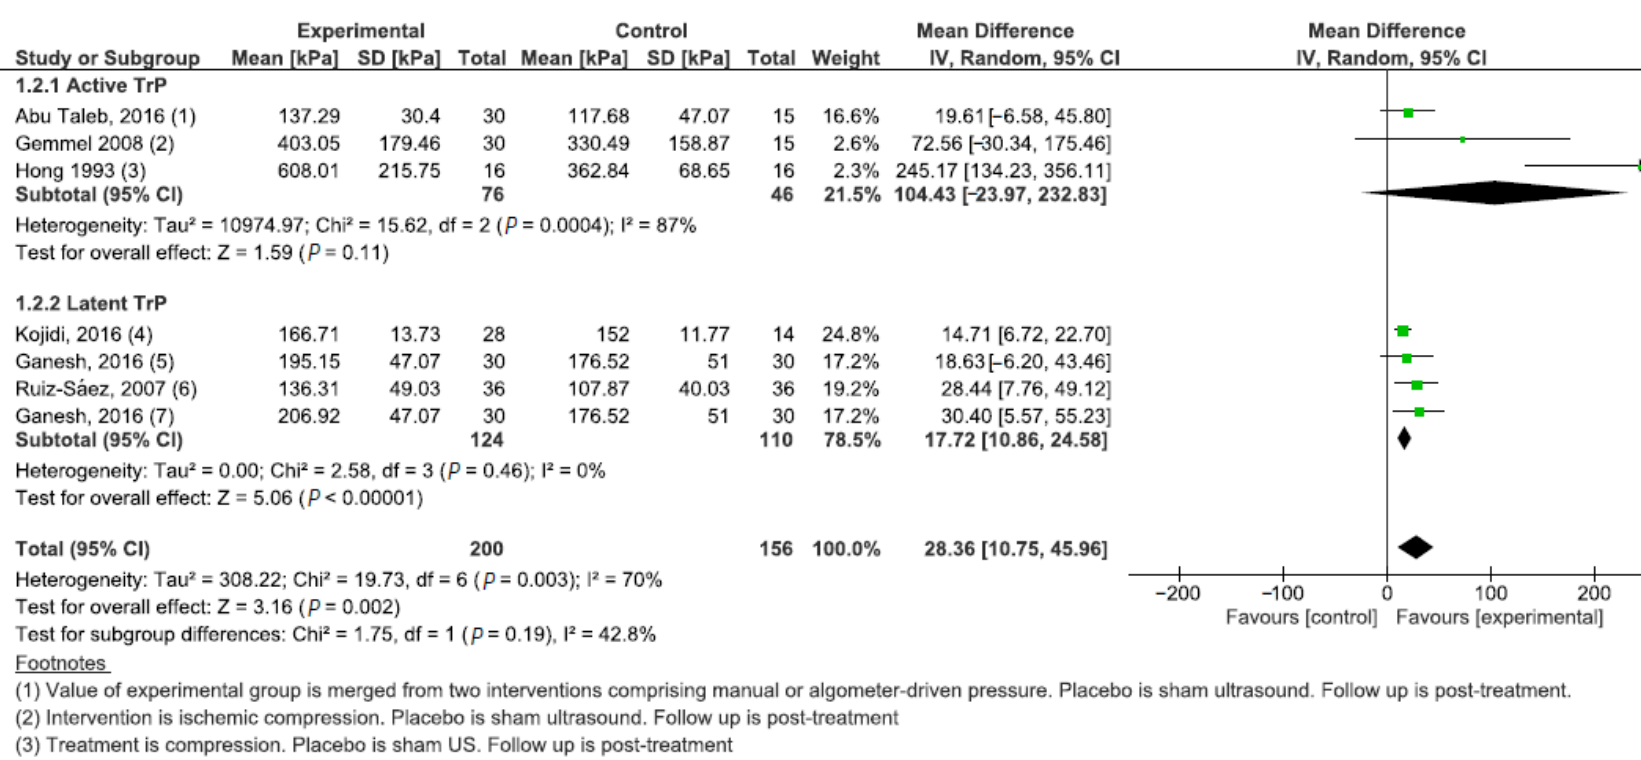
Figure 4. Forest plot for the comparison between manual intervention and minimal active treatment for active and latent TrPs.